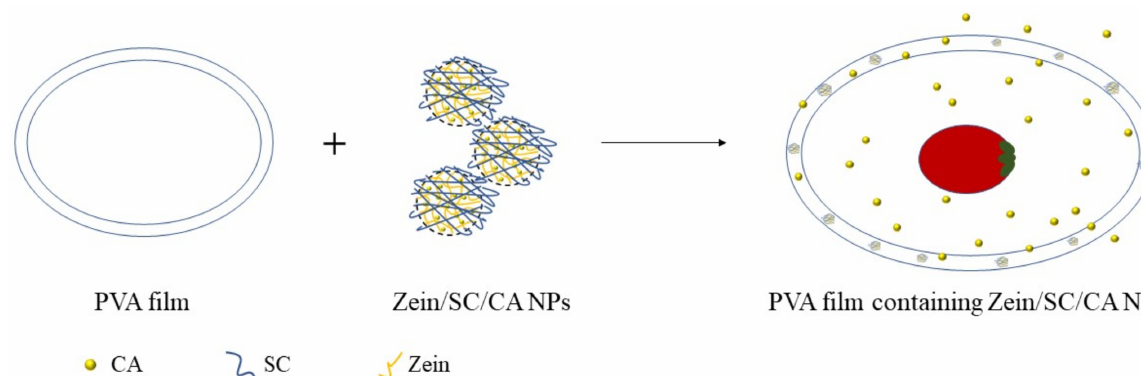
Figure 15. Schematic illustration of films containing CA-loaded composite nanoparticles for keeping food